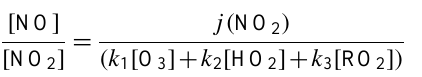
correlates with the radical production rate.